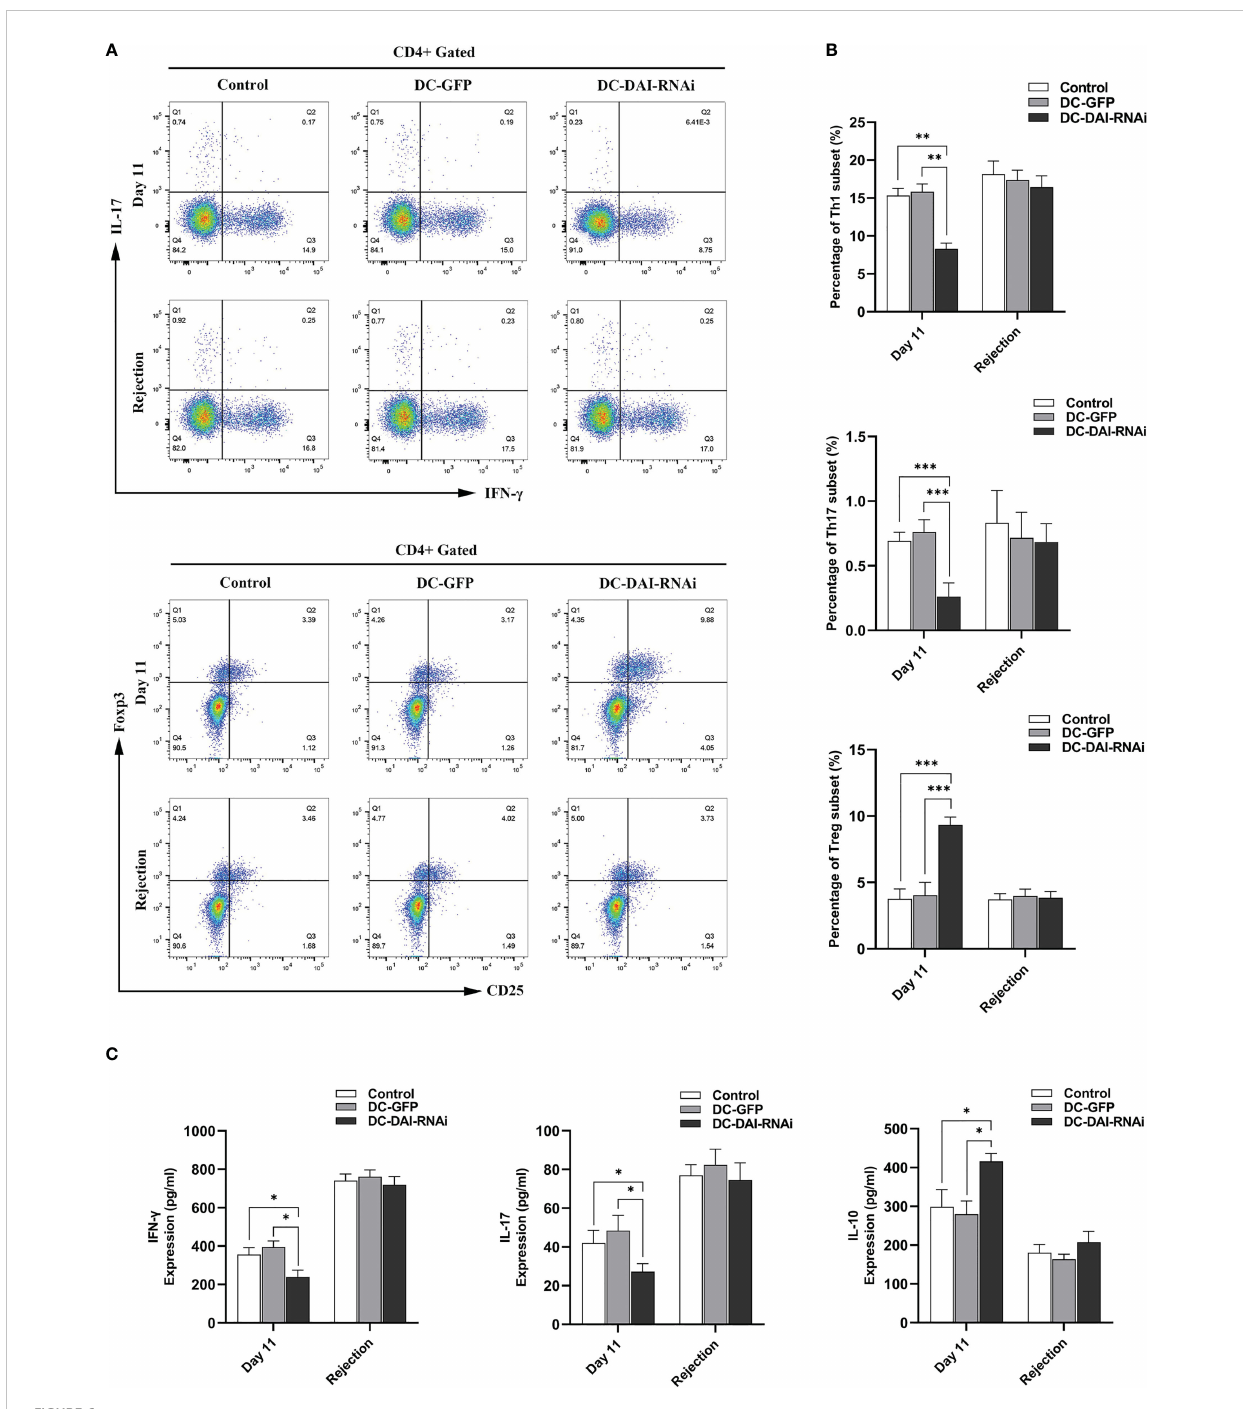
FIGURE 6 DC-DAI-RNAi reduced the populations of Th1 and Th17 cells and their secreted cytokines while induced Treg cell expansion and increased the IL-10 level in islet transplantation recipient mice. (A, B) The proportions of Th1, Th17, and Treg cells in the spleens of the PBS control, DC-GFP, and DC-DAI-RNAi groups on day 11 after islet transplantation and on the day of allograft rejection (**P < 0.01, ***P < 0.001, n=5). (C) Cytokine levels in serum were analyzed on day 11 after islet transplantation and on the day of allograft rejection. Data represent the mean ± SD (*P < 0.05,